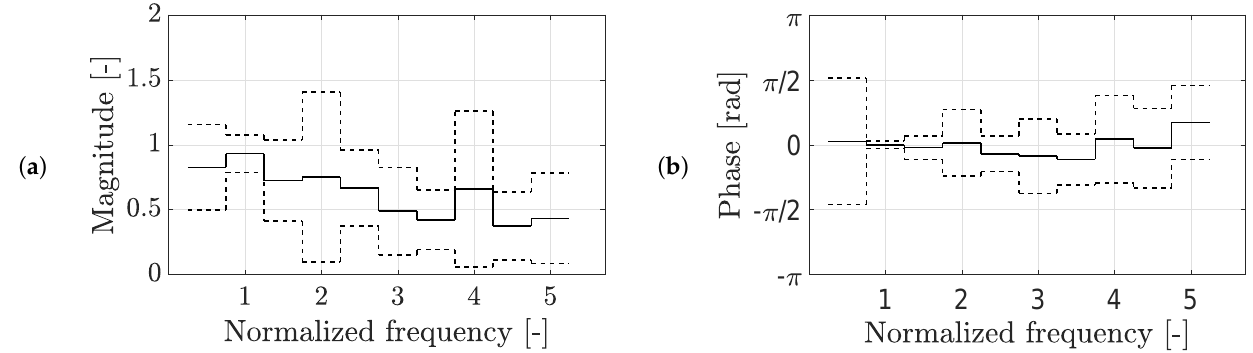
Figure 8. The averaged stochastic transfer function: mean (solid line) and 95% confidence bounds (dashed lines) of the ( a ) magnitude and ( b ) phase value. The frequency is normalized to the average step